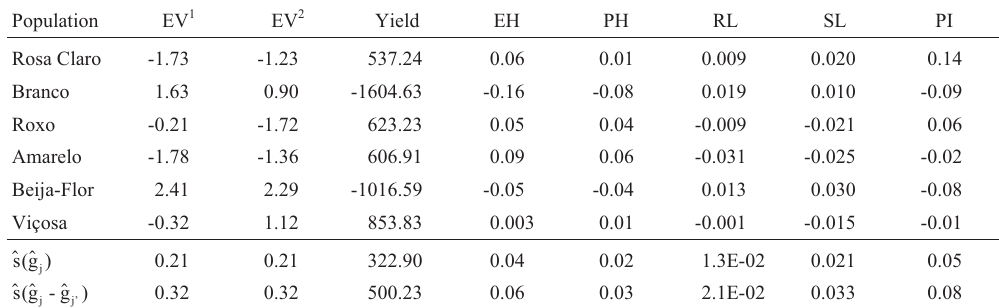
Table3 -Estimatesofgeneralcombiningabilityeffectsofpopcornpopulationsforexpansionvolume(EV,mL/g),yield(kg/ha),plantheight(PH,m),ear height (EH, m), proportion of root lodged plants (RL), proportion of stalk lodged plants (SL) and prolificacy index (PI), and standard deviation estimates of the effects and contrasts.